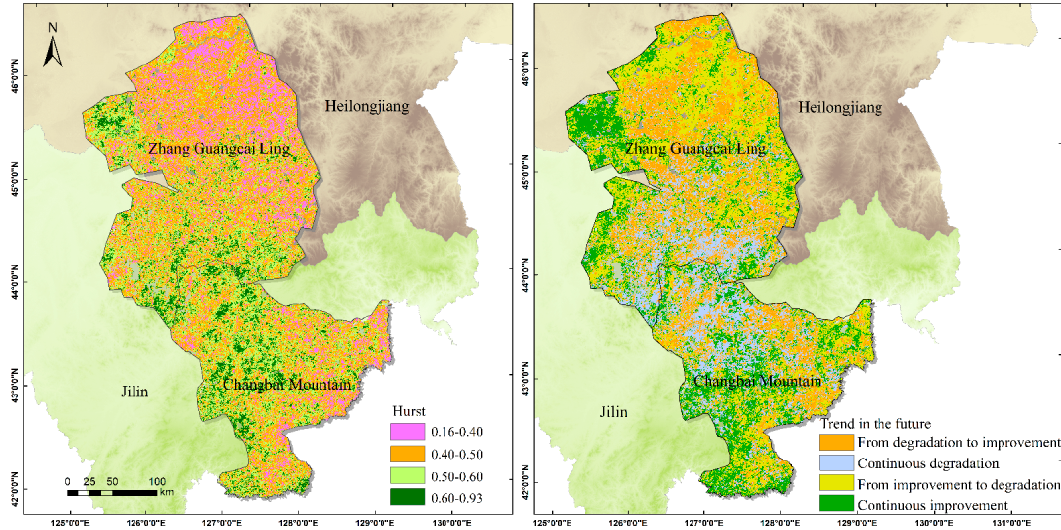
Figure 10. Hurst index and future trend of NPP in Northeast China, during 2001–2019.